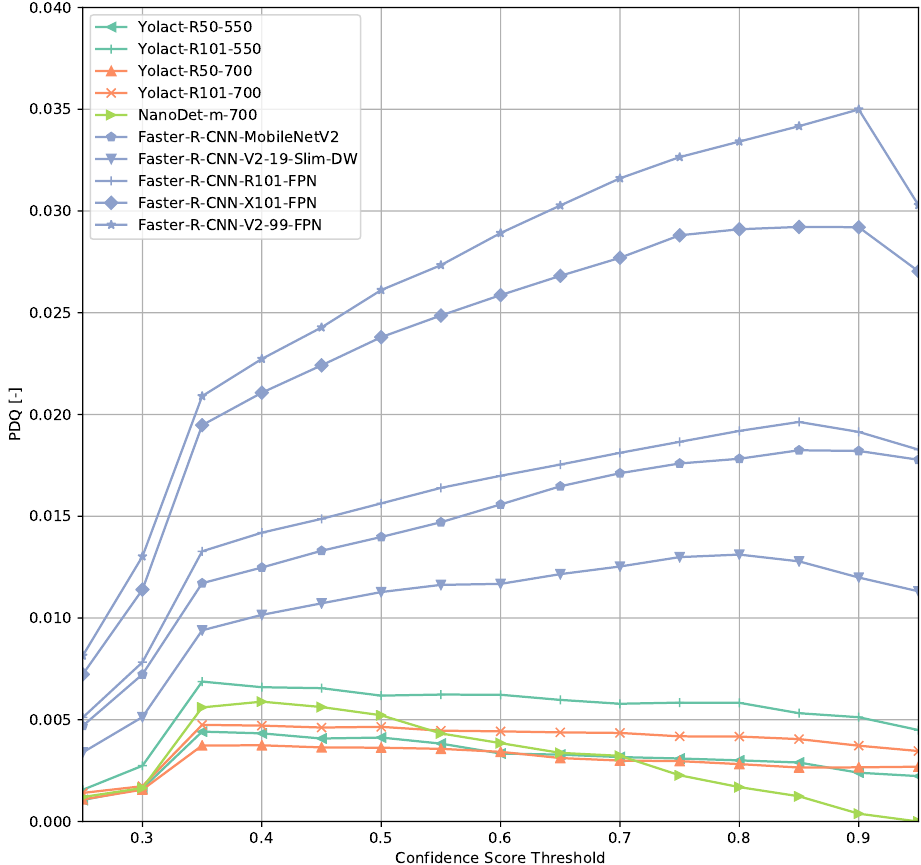
Figure 15. PDQ results on